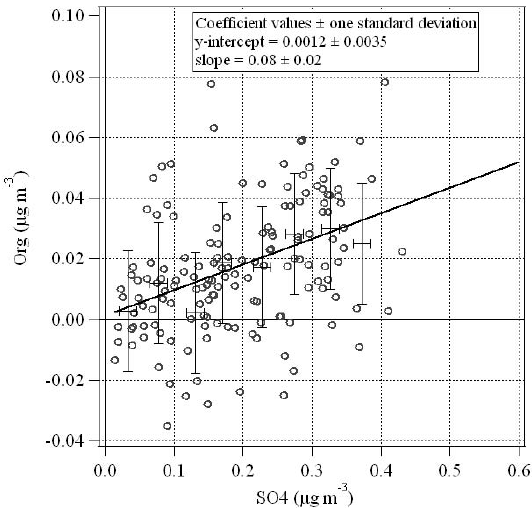
Fig. 6. Natural Org vs. SO 4 (e.g. Org vs. SO 4 for cases when CO < 56ppb and BC mass < 1.8ngm − 3 ) , one minute and bin- averaged